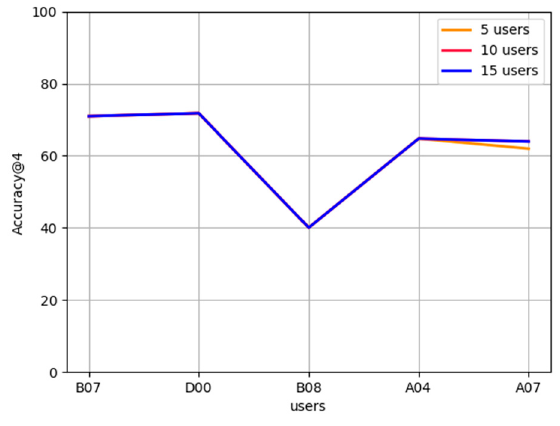
Figure 6. Effect of the number of users on FL-AHNEAP.